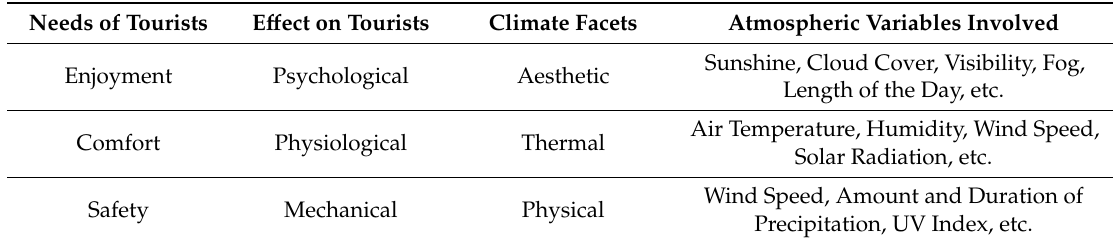
Table 3. Needs of tourists and facets of the